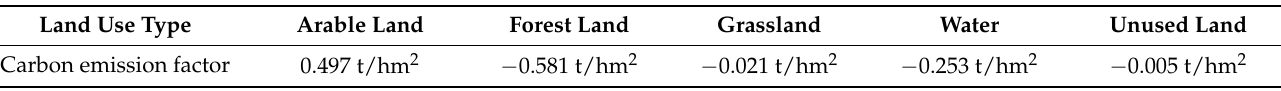
Table 1. Carbon emission coefficient for land-use